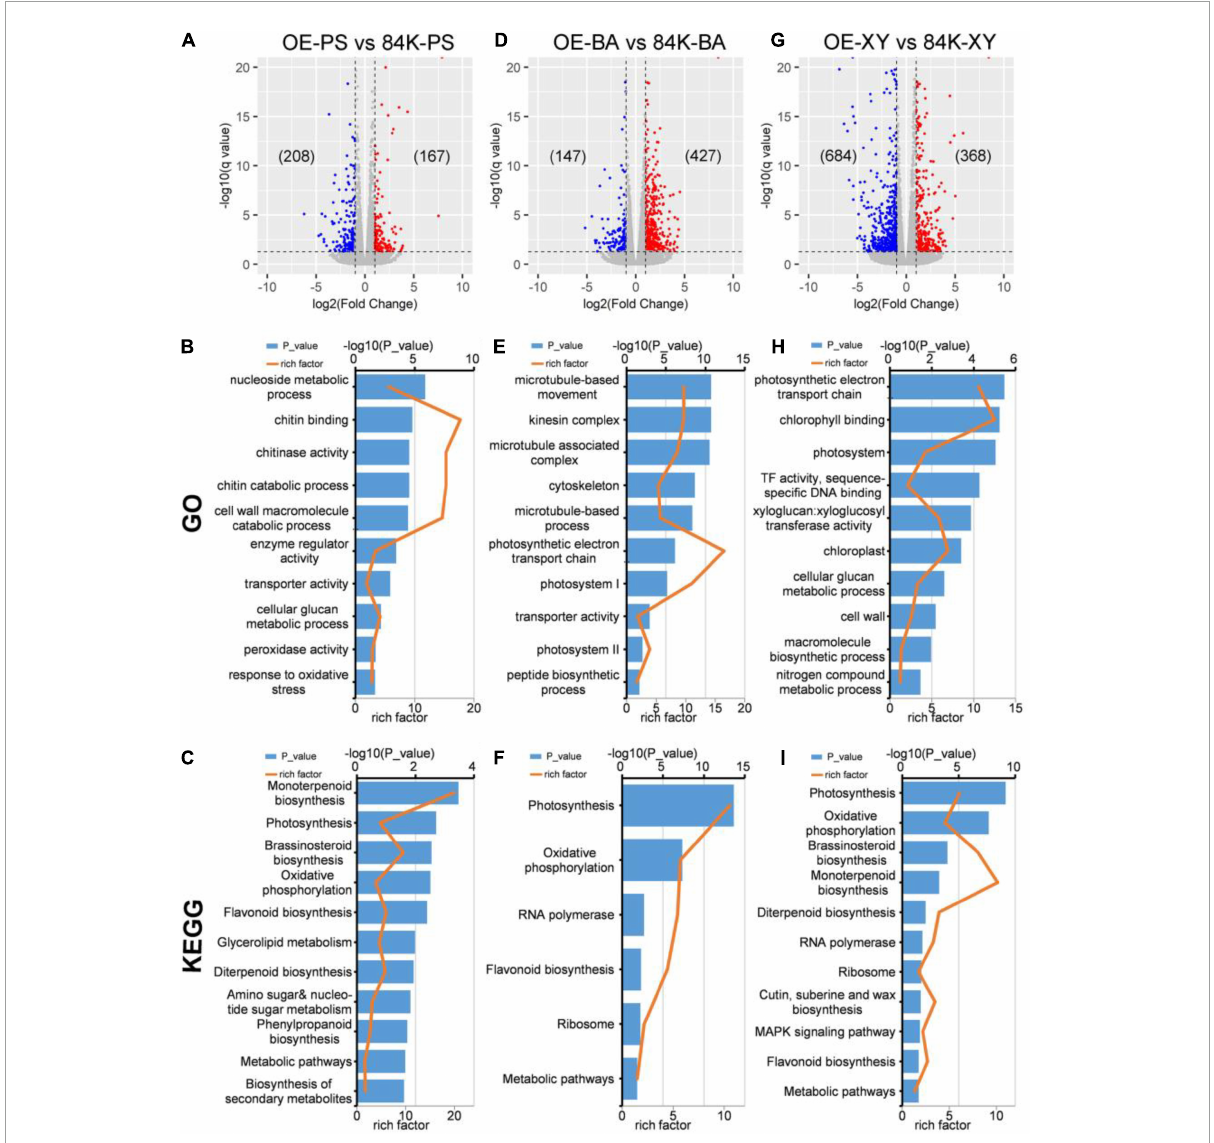
FIGURE5 DEGs analysis of wild-type and PagDET2 overexpression lines. (A–C) The volcano plot, GO enrichment analysis, KEGG enrichment analysis of PS domain; (D–F) the volcano plot, GO enrichment analysis, KEGG enrichment analysis of BA domain; (G–I) the volcano plot, GO enrichment analysis, KEGG enrichment analysis of XY domain. DEGs, differentially expressed genes; PS, primary stem; BA, bark; XY,